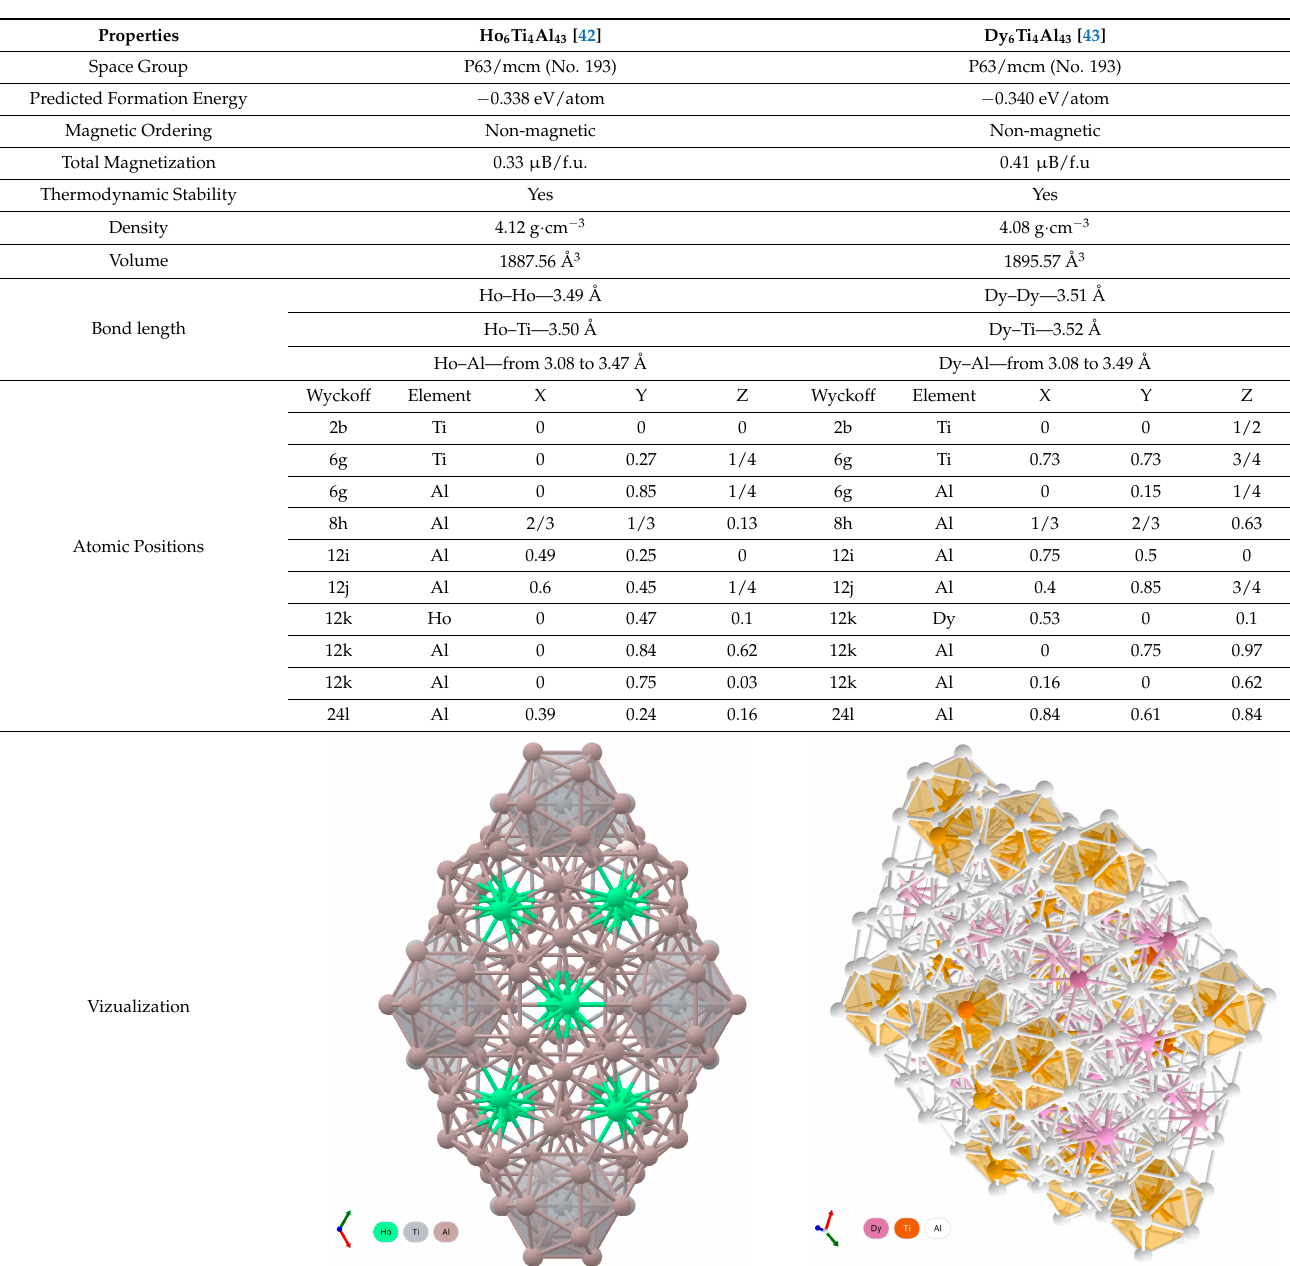
Table 4. Theoretically calculated properties of Ho ₆ Ti ₄ Al ₄₃ and Dy ₆ Ti ₄ Al ₄₃ .